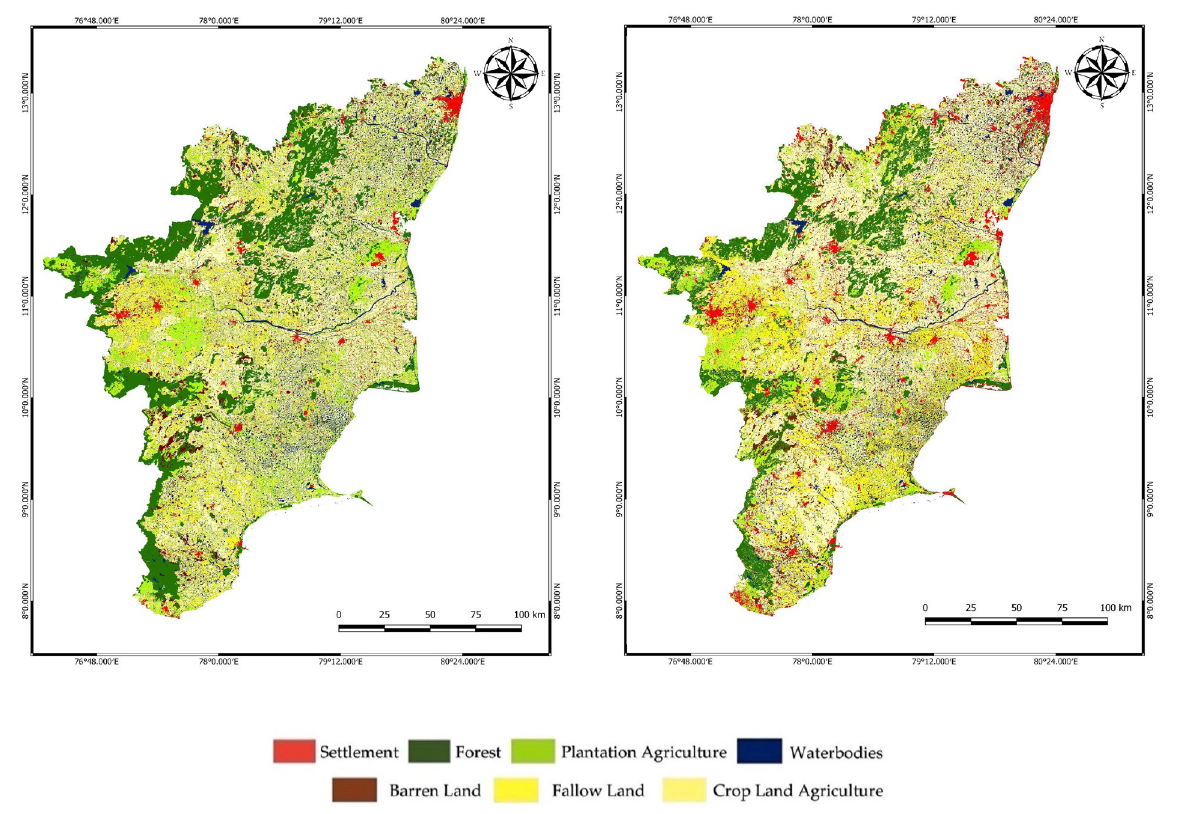
Figure 3. LULC classification map for 2000 ( Left ) and 2020 ( Right ). Table 5. Comparative analysis between various classes over two decades.